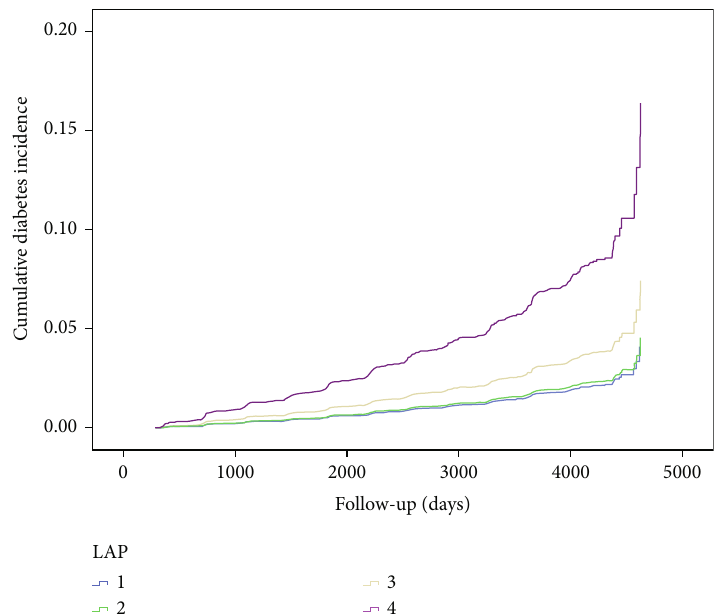
Figure 2: Cumulative prevalence of type 2 diabetes mellitus (T2DM) according to the lipid accumulation index (LAP) quartile